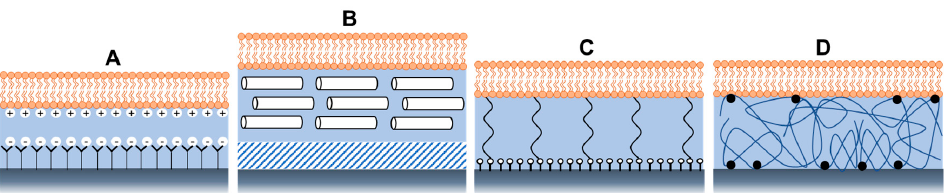
Figure 5 . Architectures of supported lipid bilayers, using ( A ) Self-assembled monolayers with a charged head group, ( B ) soft polymer cushion, ( C ) using hydrophilic (low molecular weight) spacer molecules, and ( D ) using a hydrophilic polymer